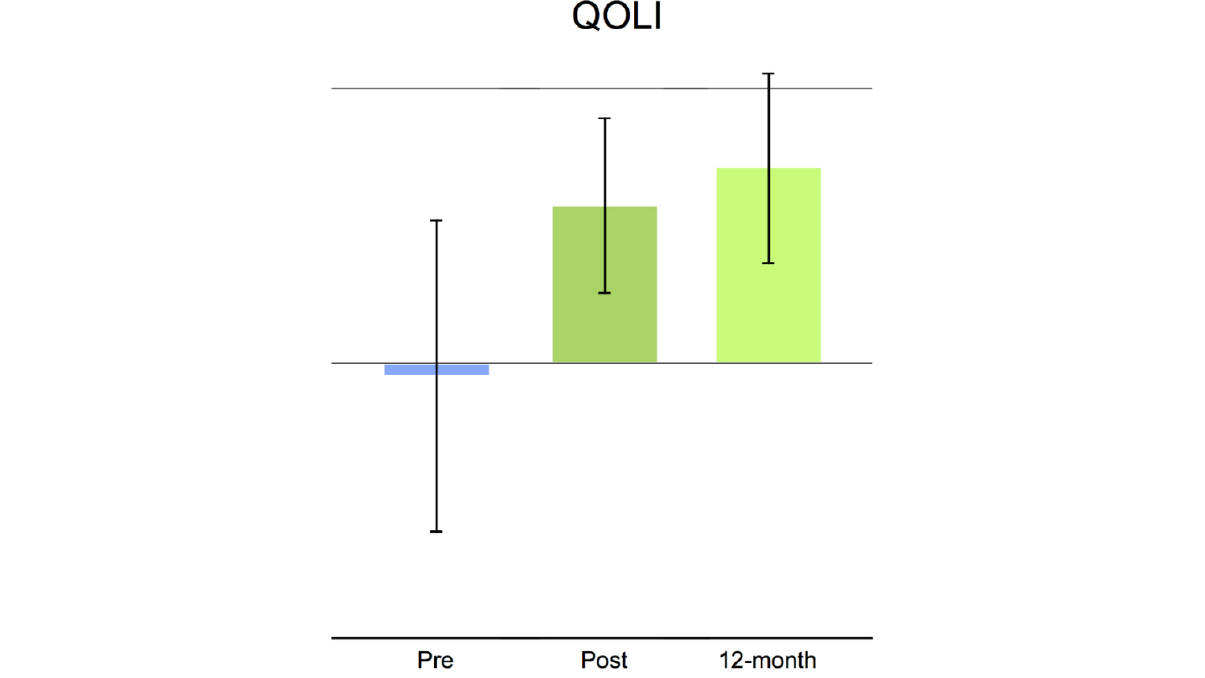
Figure 4. Histogram showing clinical measures on quality of life. Mean values at pre-treatment, post-treatment, and at 12-month follow-up. Error bars represent the standard